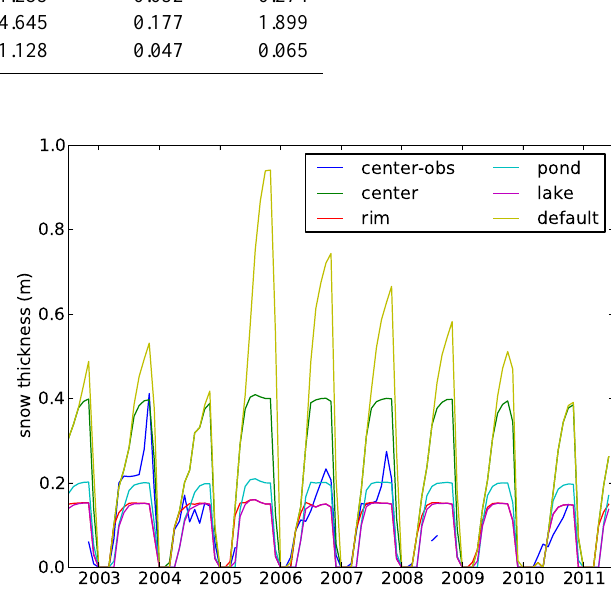
Figure 5. Comparisons of simulated maximum (monthly) snow thicknesses at the center, rim, pond, and lake sites, and the default values (with no maximum snow thickness set), with those from field measurements at the center site (center-obs), over the period from 2003 to